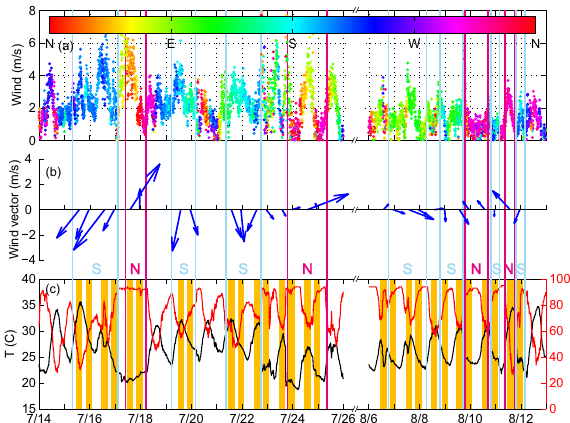
Fig. 3. Series of meteorological parameters during the campaign. (a) shows wind time series with different colors of dots indicat- ing wind directions. (b) shows 6h average wind vector during each aerosol sampling period. (c) shows temperature and RH time series. The orange bars indicate the sampling periods using BLPI. Sam- ples are classified into two patterns: the northerly pattern (N) and the southerly pattern (S) and a few samples are not classified into any